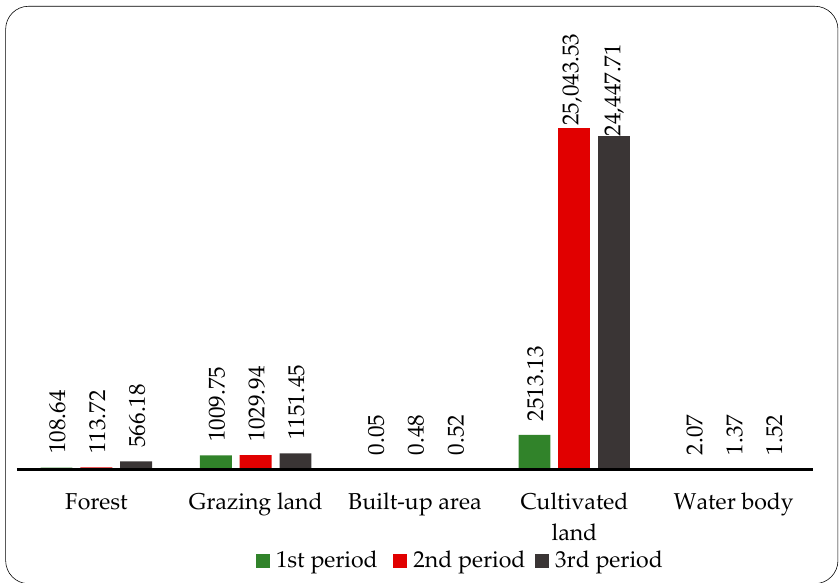
Figure 5. Land use transitions towards Eucalyptus plantation for the three